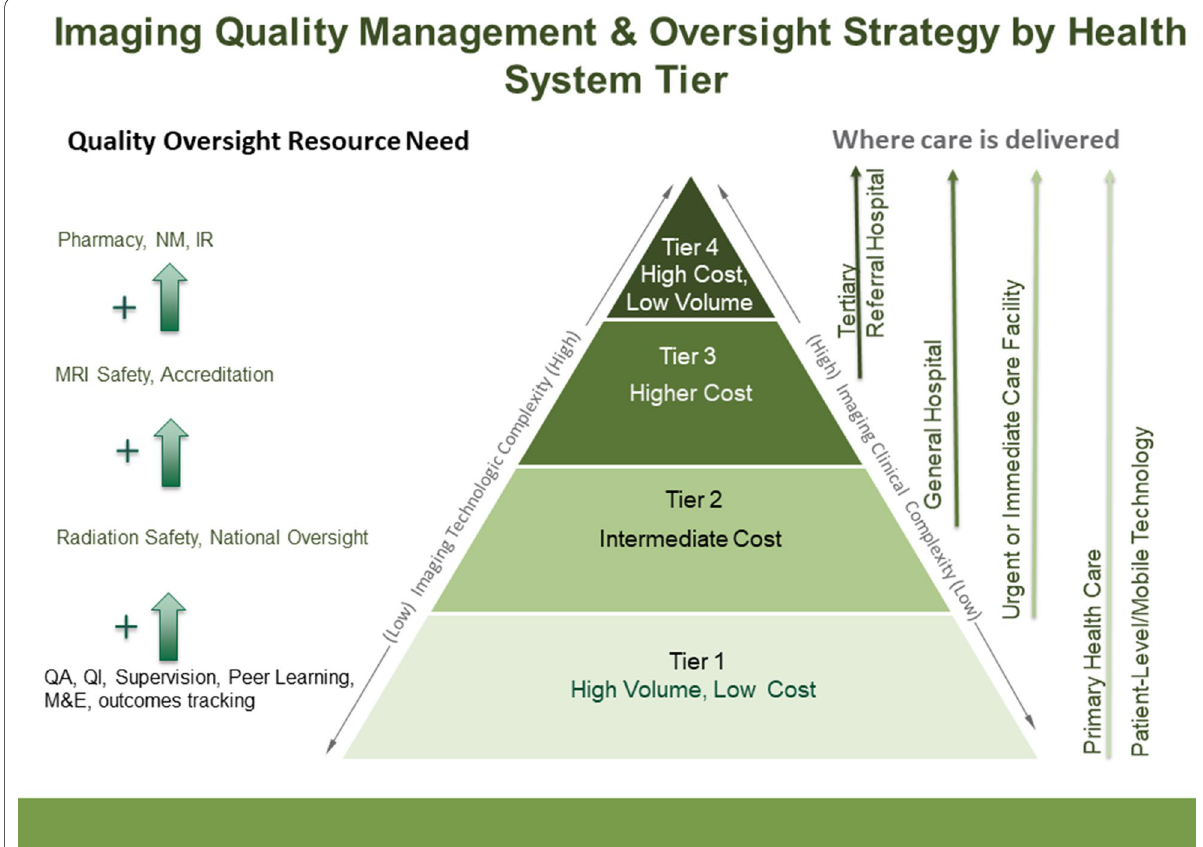
Fig. 6 Recommended imaging quality management and oversight resource strategy by health system tier. Higher levels on the pyramid denote increasing complexity and additional requirement for more sophisticated, specialized quality management and oversight. Green arrows indicate added quality and oversight needed at the next highest tier (QA MRI magnetic resonance imaging; NM =